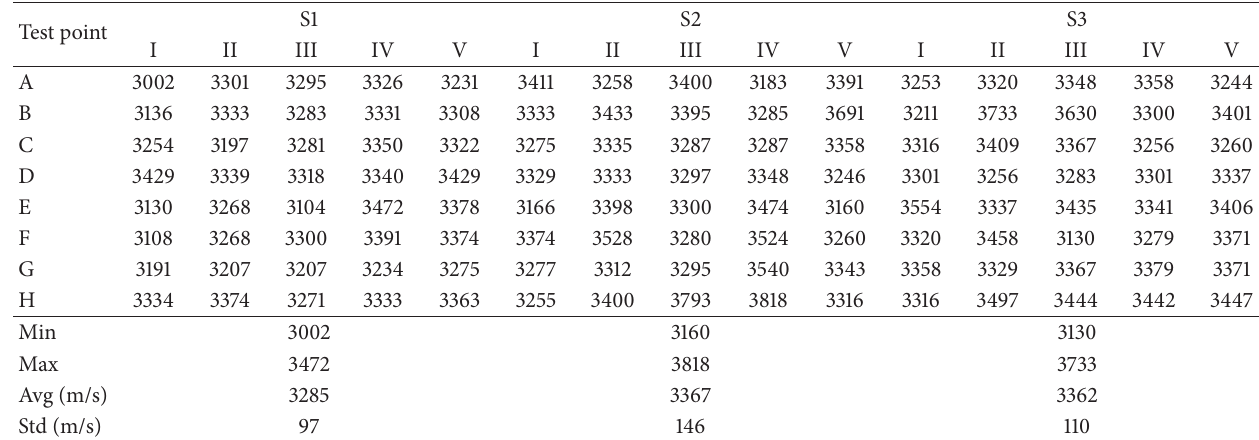
Table 2: P-wave velocities (m/s) at test grid points in slabs S1, S2, and S3.